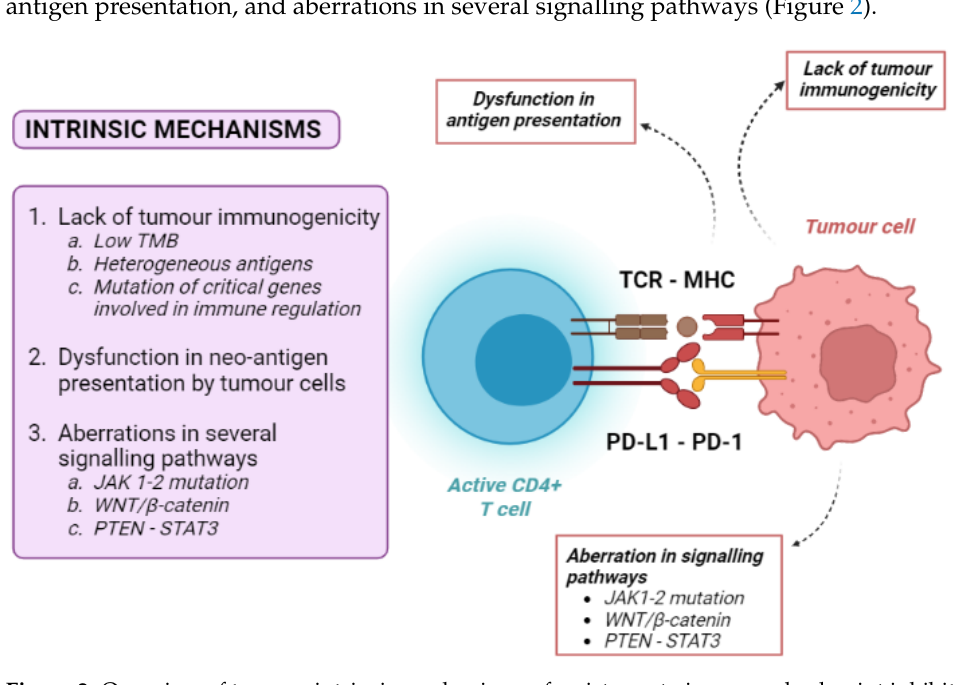
Figure 2. Overview of tumour-intrinsic mechanisms of resistance to immune checkpoint inhibitors. MHC: major histocompatibility complex; TCR: T-cell receptor; CD: cluster differentiation; PD-1: programmed death-1; PD-L1: programmed death 1-ligand.